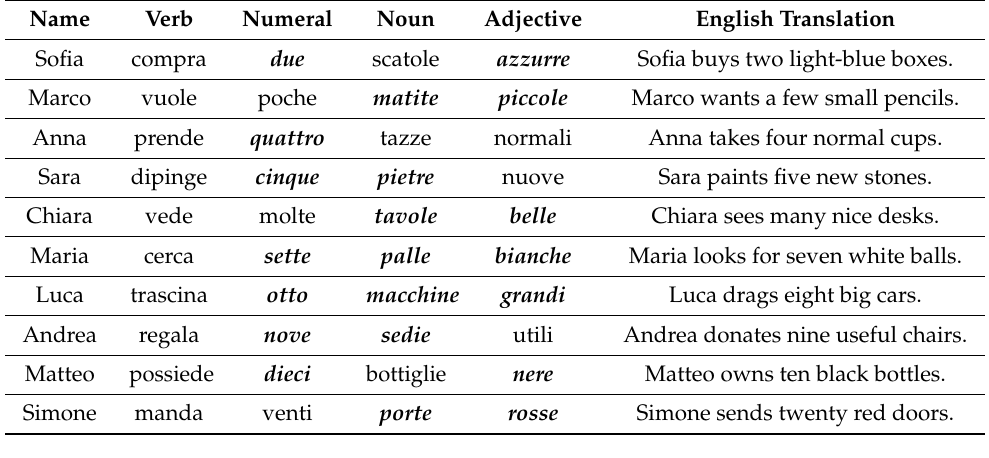
Table 1. Base matrix of ITAMatrix test [13] and selected words (italics/bold with a gray background) for the simplified ITAMatrix.